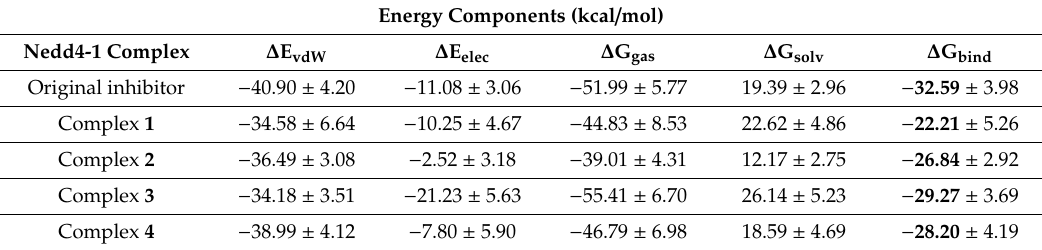
Table 3. MMGBSA-based binding free energy profiles of original compound and compounds 1 – 4 at the allosteric site of